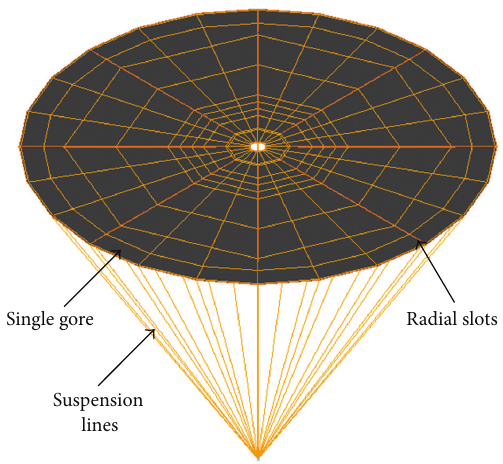
Figure 1: Slot-parachute